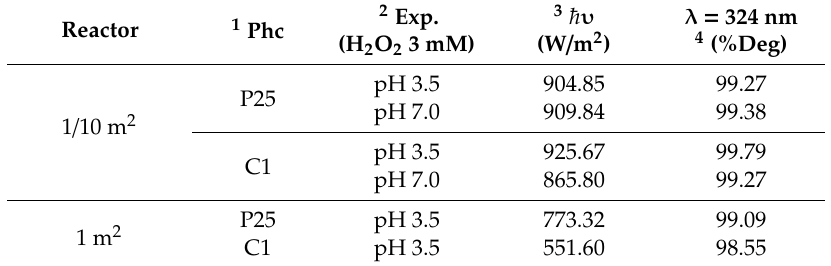
Table2. Degradatione ffi cienciesof6-MPinaqueoussolutionbysolarheterogeneousphotocatalysiswith two photocatalysts: TiO 2 P25 and C1-TiO 2 . 6-MP initial concentration was 25 mg / L in all experiments.